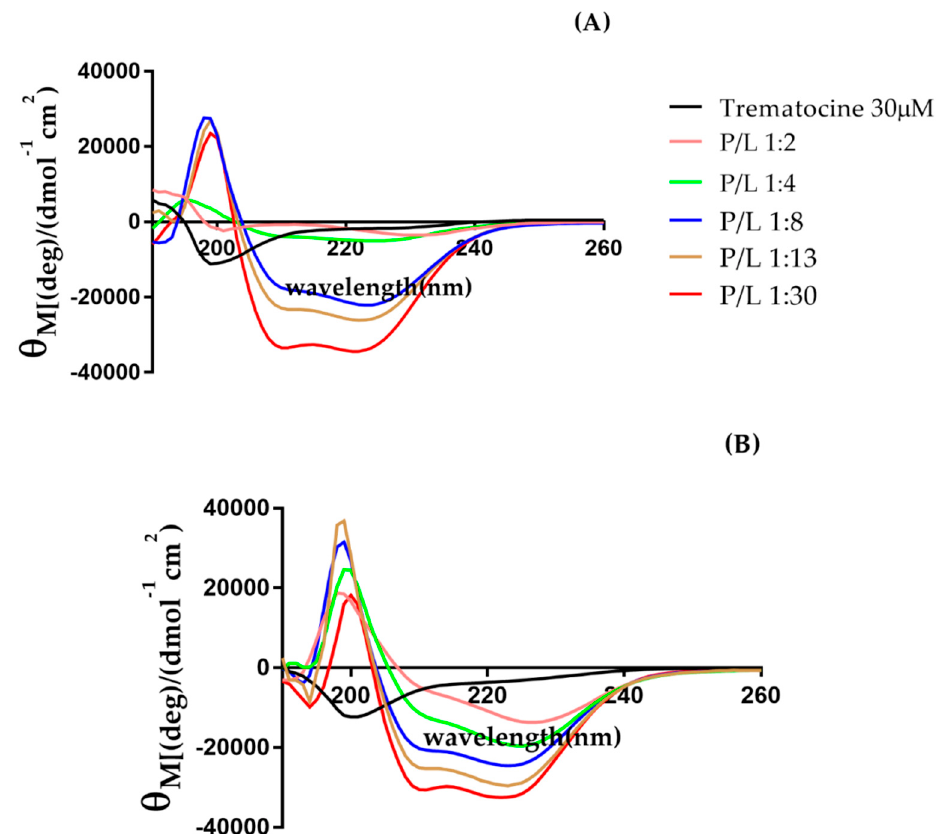
Figure 4. Circular dichroism spectra for Trematocine upon addition ( A ) 1-palmitoyl-2-oleoyl-sn-glycero-3-phosphoethanolamine (PE)/1-palmitoyl-2-oleoyl-sn-glycero-3-phosphoglycerol (PG) (3:1) large unilamellar vesicles (LUVs), and ( B ) 100% 1-palmitoyl-2-oleoyl-glycero-3-phosphocholine (PC) LUVs. P/L ratios are expressed in mol/mol, and the raw signal is corrected in Ѳ M .